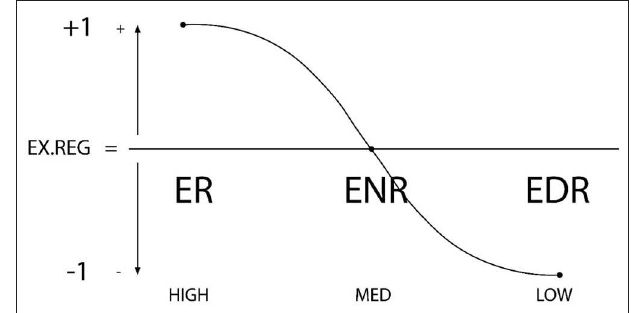
FIGURE 1 | Graphic representation of regulation types: SR, Self-regulation; NR, Non-regulation; DR, Dys-Regulation. The X axis represents the degree of regulation (high-medium-low), while the Y axis shows directionality ( + 1, 0, − 1).